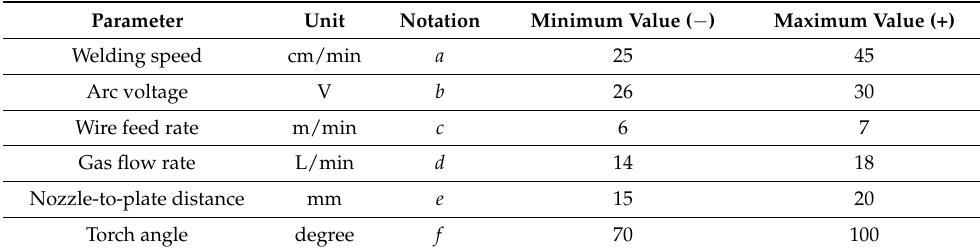
Table 3. Input parameters for MIG process [2].